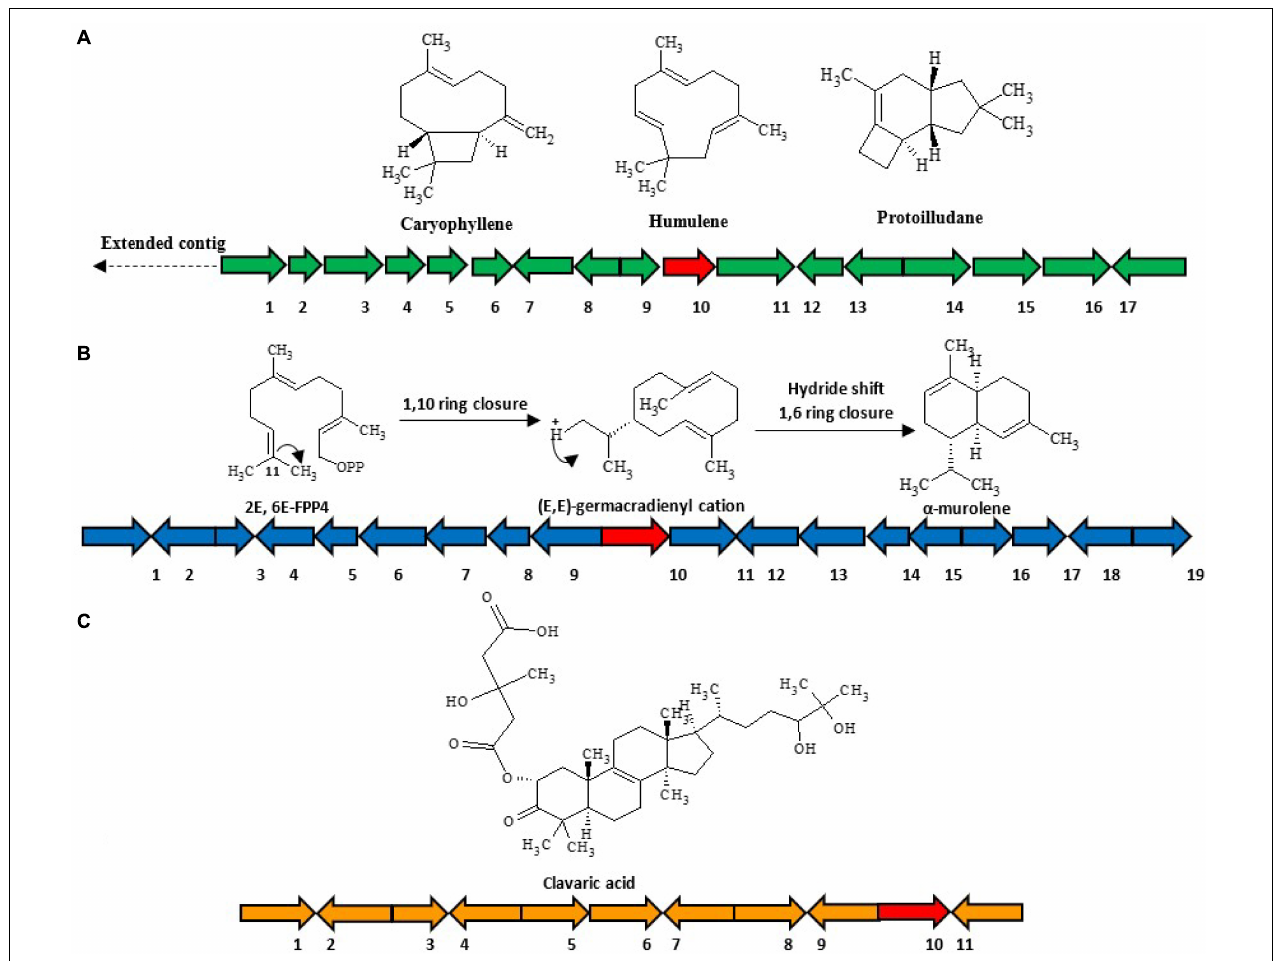
FIGURE 3 | Selected sesquiterpene biosynthetic gene clusters of 1,11 E,E-FPP carbon cyclization clade identified in the Hypholoma fasciculare genome and their likely initial products. (A) HfasTerp-94a and HfasTerp-94b biosynthetic gene clusters and examples of likely products—caryophyllene, humulene, and protoilludane—illustrating the 1,11 carbon cyclization pattern predicted for this synthase. 1 = Serine/threonine kinase; 2 = Zinc carboxypeptidase; 3 = Hypothetical protein; 4 = Short-chain dehydrogenase 1; 5 = Short-chain dehydrogenase 2; 6 = Short-chain dehydrogenase 3; 7 = Tyrosinase; 8 = F-box domain; 9 = Anchor signaling protein; 10 = Terpene synthase B; 11 = Splicing co-activator; 12 = F-box domain; 13 = Glucose transporter; 14 = Peptide transporter; 15 = Terpene synthase A; 16 = Aromatic ring hydroxylase; 17 = Glycoside hydrolase. (B) HfasTerp-179 biosynthetic gene cluster (BGC) and examples of likely products arising from the predicted 1,10 carbon cyclization for this synthase. 1 = Alpha/beta-hydrolases; 2 = Aspartyl protease; 3 = E3 ubiquitin–protein ligase; 4 = NAD-dependent histone deacetylase; 5 = Hypothetical protein; 6 = Transcription factor; 7 = GMC oxidoreductase; 8 = Hypothetical protein; 9 = Cytochrome P450; 10 = Terpene synthase; 11 = GMC oxidoreductase; 12 = Fructose 2,6-bisphosphatase; 13 = Kinase like protein; 14 = Hypothetical protein; 15 = DNA repair endonuclease; 16 = Telomerase transcriptase; 17 = Monooxygenase FAD; 18 = Glycoside hydrolase; 19 = Alpha ketogluturate. (C) HfasTerp-804 BGC predicted to be responsible for the production of the antitumor clavaric acid or similar derivatives. 1 = Hypothetical protein; 2 = Flavin-containing amine oxidase; 3 = Pyruvate decarboxylase; 4 = Cytoplasmic protein; 5 = Phosphomannomutase; 6 = Delta DNA polymerase; 7 = Putative transcription factor; 8 = 60S ribosomal protein translation; 9 = Actin-related protein; 10 = Oxidosqualene clavarinone cyclase; 11 = Nuclear condensin